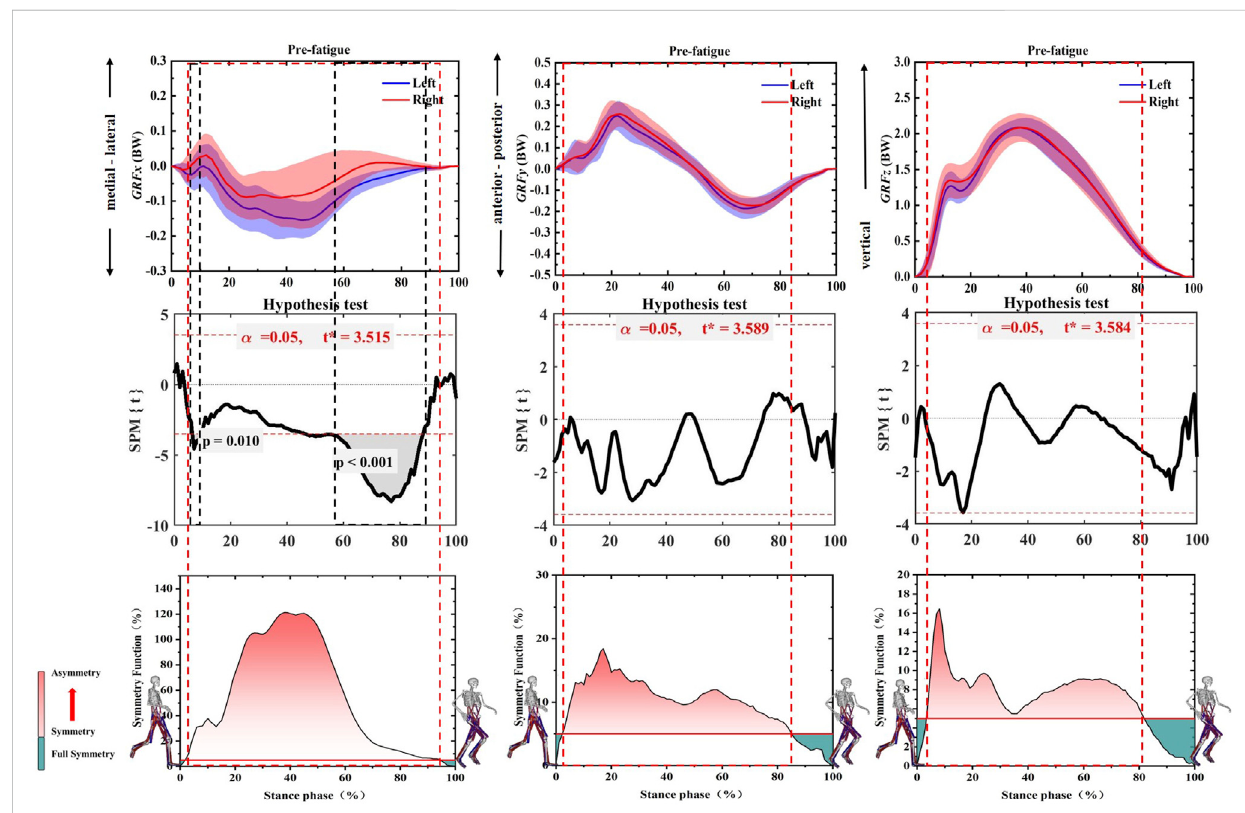
FIGURE 2 Illustration of SF degree and SPM test of GRFx, GRFy, and GRFz during the whole gait stance phase before Running-induced Fatigue Protocol Test. Note: The red dotted boxes represent asymmetrical degrees. The black dotted boxes represent a signi fi cant difference ( p < 0.05). The red fi ll represents the degree of asymmetry, and the darker the color, the more asymmetry. The green fi ll represents full symmetry. GRFx: medial-lateral direction of GRF, GRFy: anterior-posterior direction of GRF, GRFz: vertical direction of